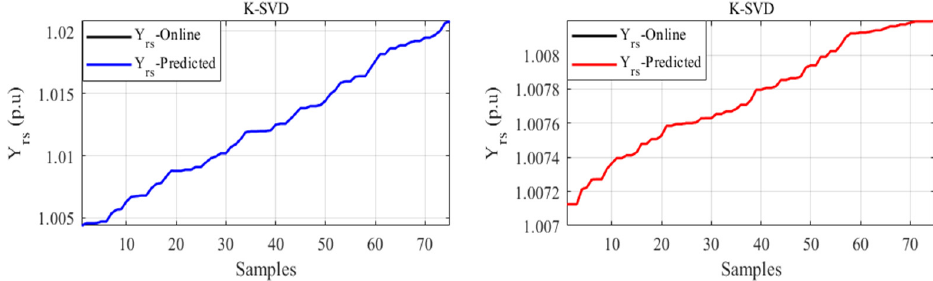
Figure 5. Online & K-SVD reconstruction of stable (blue) and unstable (red) of sample signal’s response in the test dataset.